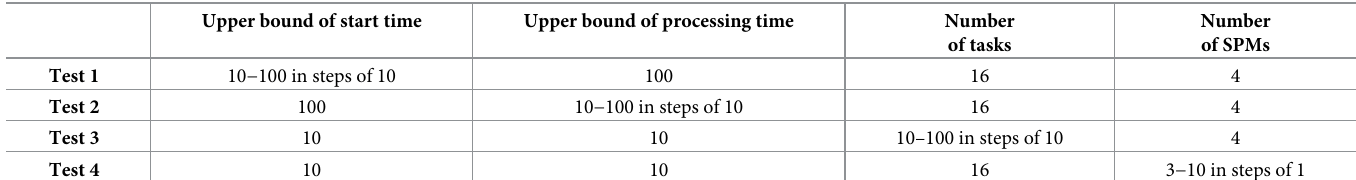
Table 2. Experiment settings.